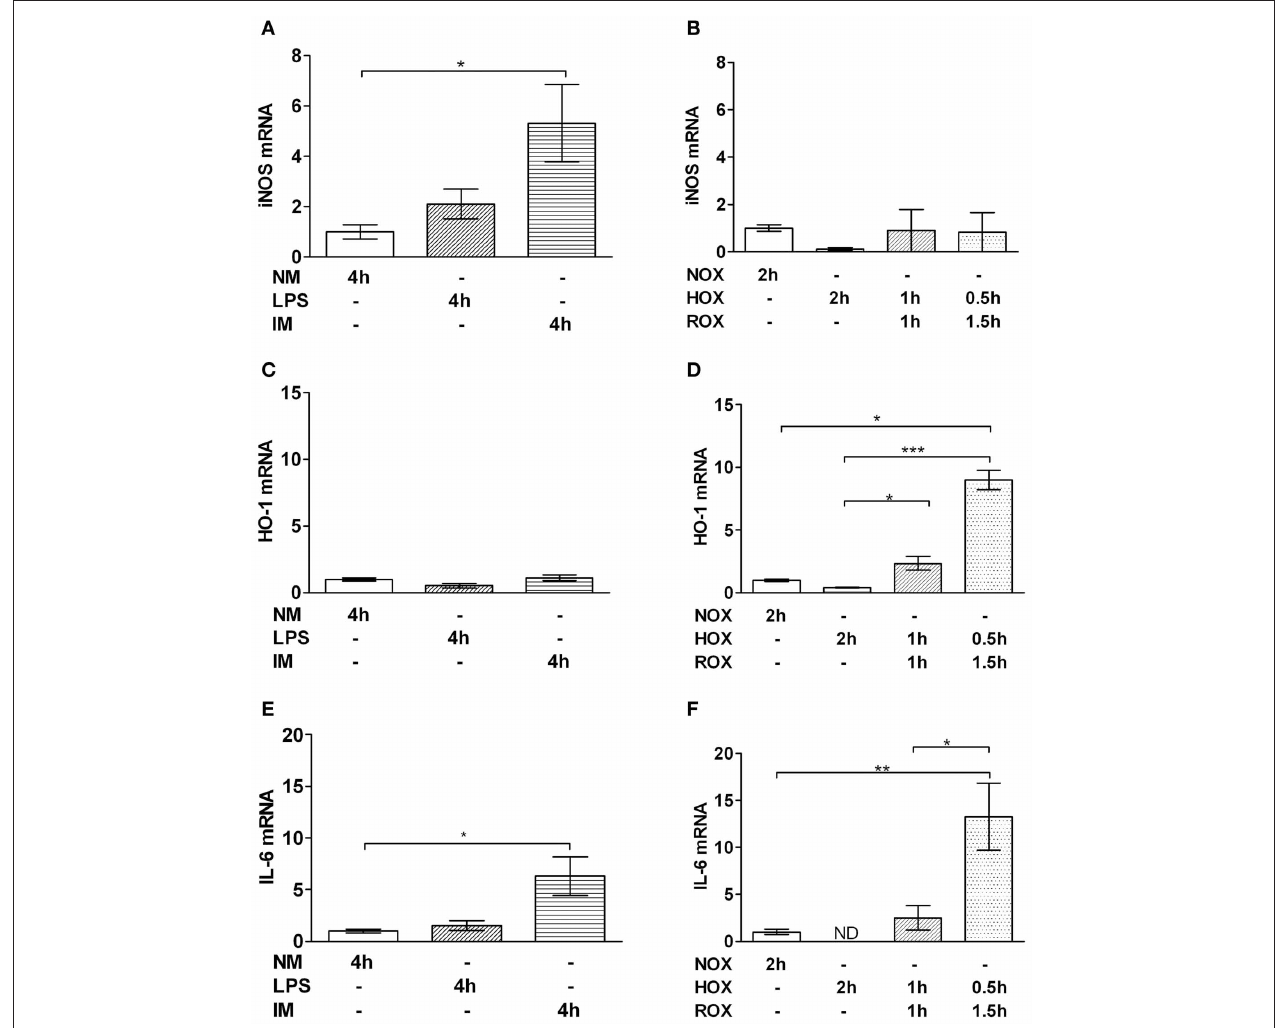
∗∗∗ p < 0 . 001. mRNA expression is represented as fold increase of the corresponding control. Abbreviations used: iNOS, inducible nitric oxide synthase; HO-1, heme oxygenase 1; NM, normal medium; LPS, lipopolysaccharide; IM, inflammatory mediators; NOX, Normoxia; HOX, Hypoxia; ROX, reoxygenation; PCLS, precision cut liver slices; ND, not